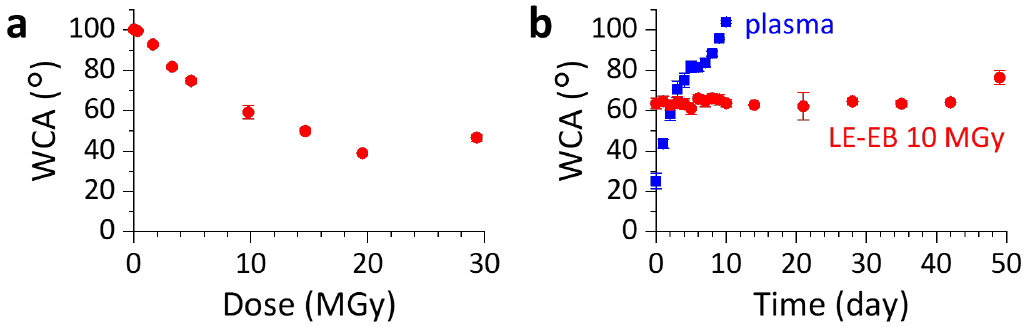
Figure 9. ( a ) Water contact angle change of low energy electron beam (LE-EB)–irradiated polydimethylsiloxane (PDMS) as a function of storage time in ultra-pure water at room temperature